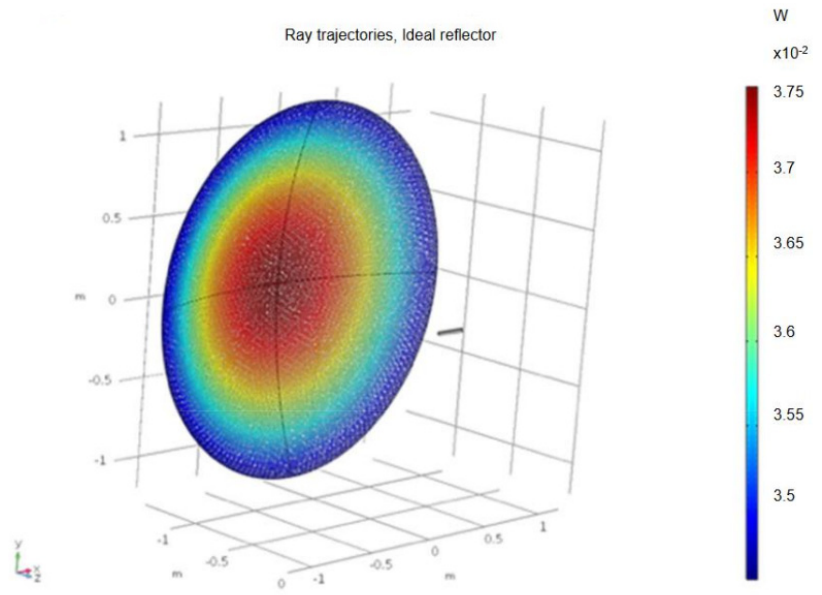
Figure 8. Distribution of incident rays on ideal reflector. The chromaticity of each point indicates the power value deposited.